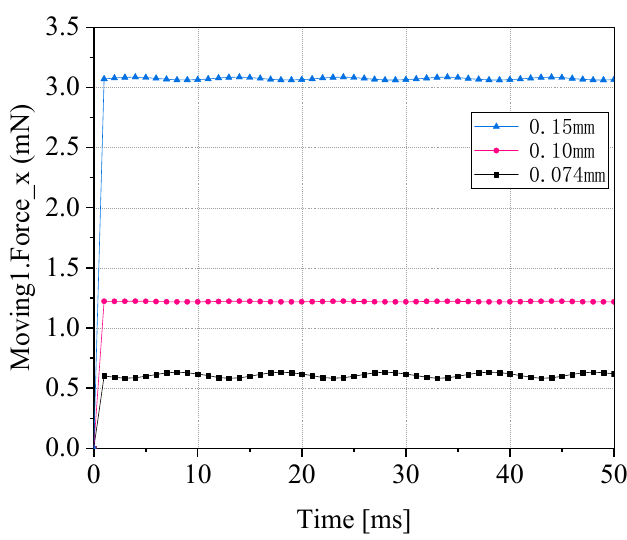
Figure 12. Electromagnetic force generated at different particle diameters.